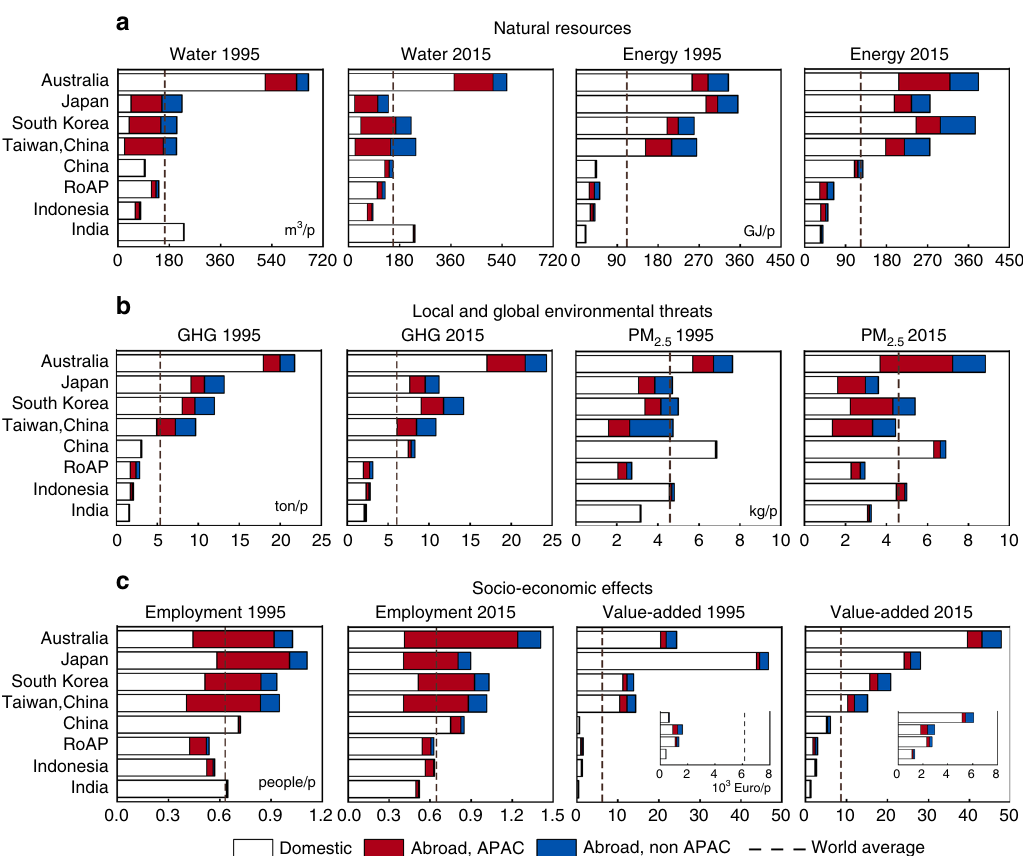
Fig. 1 The environmental-social-economic footprints of APAC countries/regions in 1995 and 2015. The six footprint indicators fall into three categories and are presented in a natural resource, b local and global environmental threats, c socio-economic effects. The eight countries/regions are aligned on the y -axis following a descending order by average income per capita in 2015. Footprints are further broken down to the impacts occurred within the country/ region, abroad in other APAC countries/regions, and abroad in non-APAC countries/regions. In each subplot, the dashed line indicates the world average level. GHG (CO 2 , N 2 O, and CH 4 ) are measured in CO 2 equivalent based on the 100-year Global Warming Potential (GWP100). Note, in the plots for value added, we use the insets to show the footprint compositions of the last four countries/region. China refers to Chinese mainland, and we call Taiwan, China as Taiwan for short in the